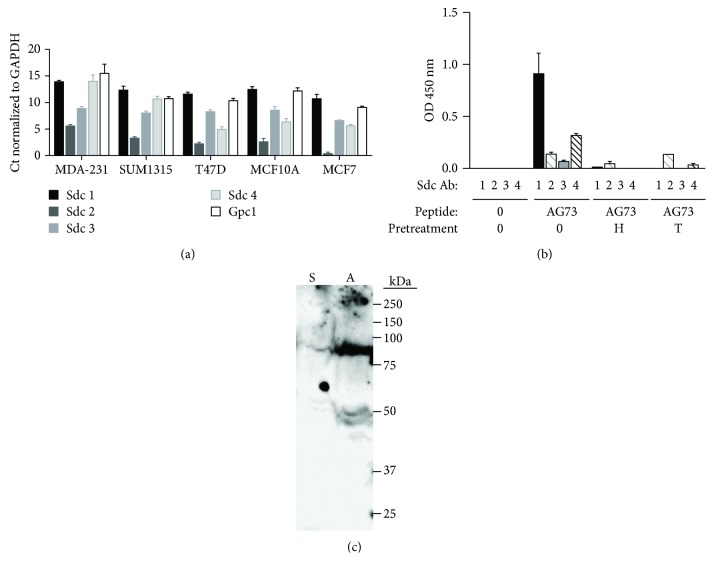
Sdcs 1-4 as well as glypican (Gpc)1 are expressed in MDA-231 cells. (a) qPCR was used to detect the message levels of each Sdc and glypican 1 (Gpc1) in breast cancer cell lines. Bars: mean Ct values are normalized to GAPDH ± SEM. All reactions were run in triplicate and repeated three times, and gene expression was normalized to the housekeeping gene GAPDH. (b) Sdcs 1 and 4 bind to AG73. For this solid-phase assay, wells were uncoated (0) or coated with AG73. Cells were pretreated with either heparin (H) or trypsin (T) before they were lysed. Controls were left untreated (0). The MDA-231 cell lysate binds to AG73 but not to the scrambled peptide (data not shown). The wells were then incubated with antibodies to Sdcs and detected using a secondary-HRP conjugate. Heparin and trypsin pretreatment inhibited Sdcs 1 and 4 binding to AG73. Bars: mean OD 450 nm ± SEM. (c) AG73 binds a >250, 90, and 50 kDa biotinylated protein from the surface of MDA-231 cells. Biotinylated MDA-231 cell membrane was incubated with AG73 (A) or scrambled peptide (S) as in (b). Proteoglycan bands usually appear as a smear due to the heparan sulfate and chondroitin sulfate glycosaminoglycan chains.